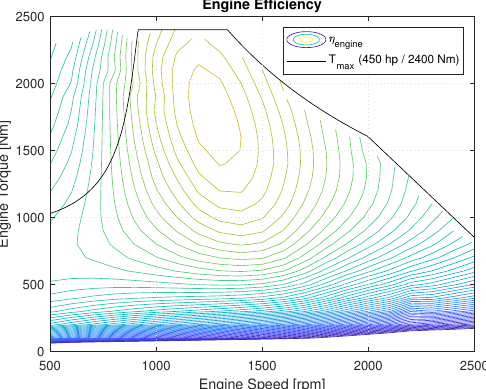
Figure 2. The stationary engine map for the MVEM. The maximum torque is set to 2400 Nm, the stationary air–fuel ratio limits the output torque to between 500 and 900 rpm, the maximum power is set to 450 hp and a high rpm cut-off is imposed at 2000 rpm. The diesel engine model’s maximum efficiency is 46%.